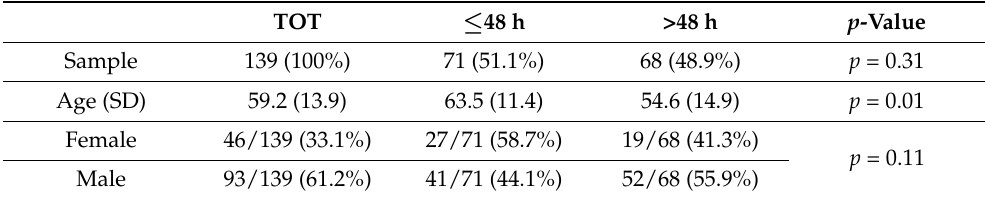
Table 1. Main demographic data of the two groups. The first group had an MRI within 48 h, while the second group had an MRI after 48 h. A p -value < 0.05 was considered statistically significant. TOT ≤ 48 h >48 h p -Value Sample 139 (100%) 71 (51.1%) 68 (48.9%) p = 0.31 Age (SD) 59.2 (13.9) 63.5 (11.4) 54.6 (14.9) p = 0.01 Female 46/139 (33.1%) 27/71 (58.7%) 19/68 (41.3%) p = 0.11 Male 93/139 (61.2%) 41/71 (44.1%) 52/68 (55.9%)